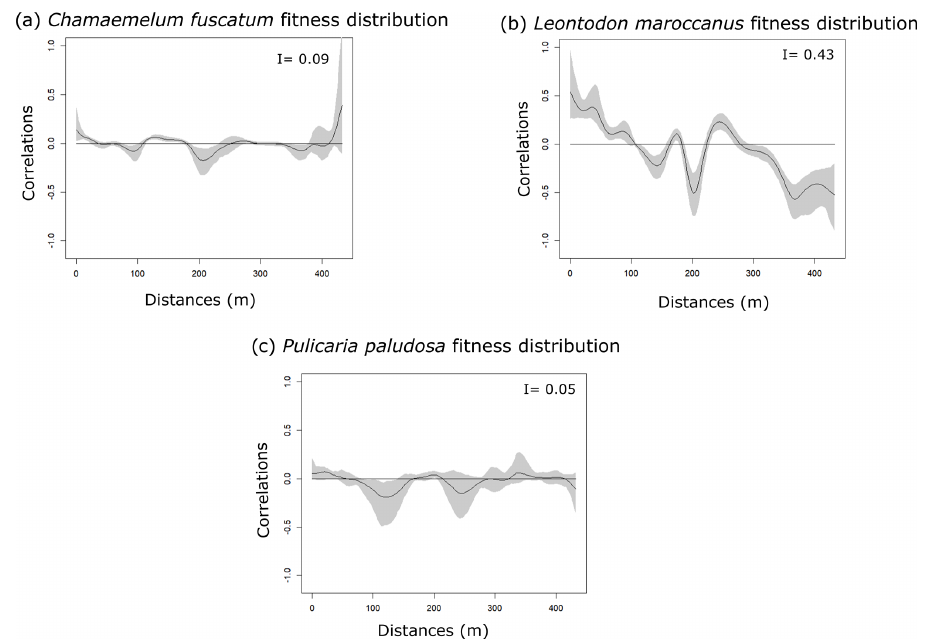
Figure A6. Spatial autocorrelation of fitness (individual total seed set) distribution of plant species. The black line is the spatial correlation value that a species has for each distance; the gray shadow indicates the 95% confidence interval. The I values are the result of Moran’s I